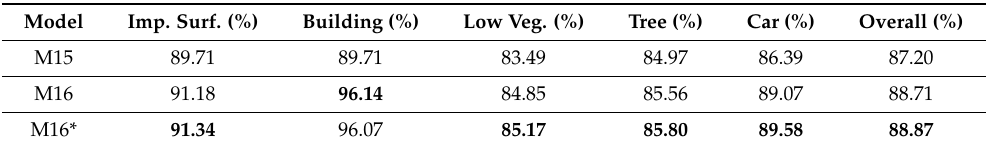
Table 8. Test scores obtained using full-dataset for dual-stream segmentation models. All quality measures except for overall accuracy are F1 scores in [%].